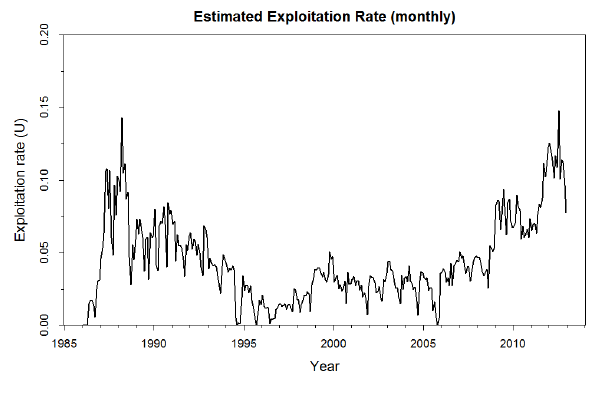
Fig. 4 . Estimated monthly exploitation rate for legal